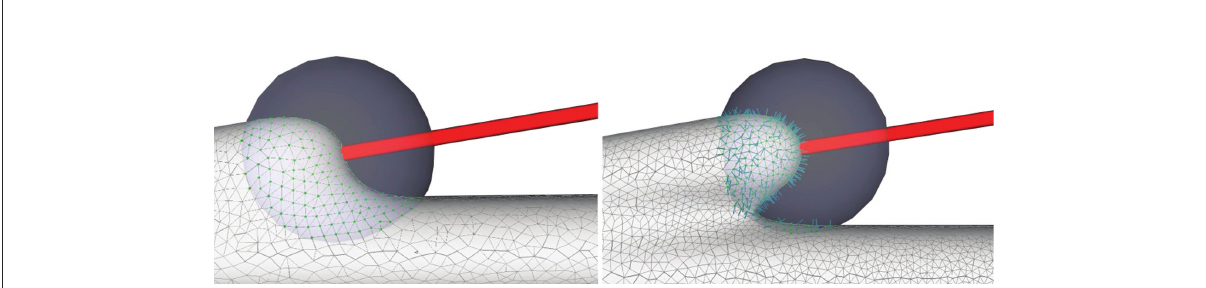
FIGURE6 Convolution surface approximation at the branching regions using progressive evolution. In a branching region, a second neurite starts to grow from the main trunk (left) , and the implicit approximation and projection produce smooth structures (right) , which is the result of both deformation of the current neurite and blending of the neighboring branches.